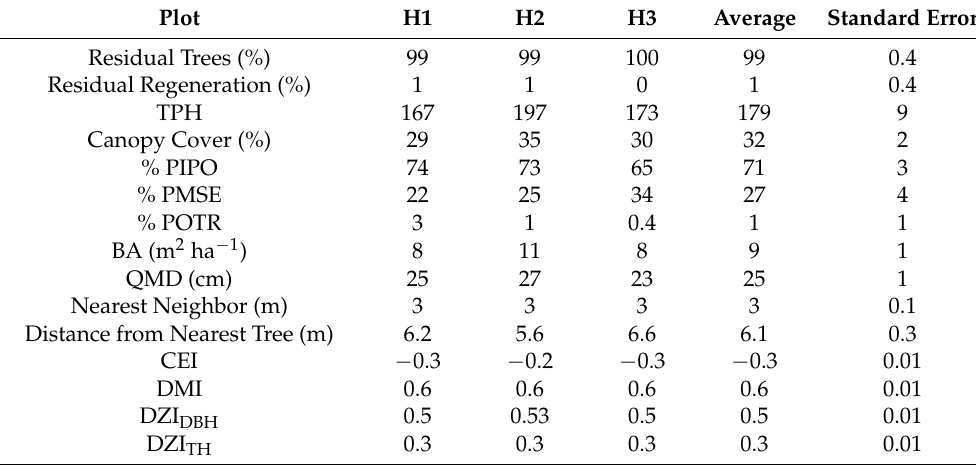
Table 2. Residual forest structure within the Hayman Fire plots (H1, H2, and H3) 11–12 years following burning. This summarization includes all conifers and aspen (POTR) which represents 0.61% of the residual trees. Measures of trees per hectare (TPH), % ponderosa pine (PIPO), % Douglas-fir (PSME), % aspen (POTR), basal area (BA), quadratic mean diameter (QMD), Clark and Evans index (CEI), Durchmischung index (DMI), horizontal differentiation (DZI DBH ), and vertical differentiation (DZI TH ) are included in this